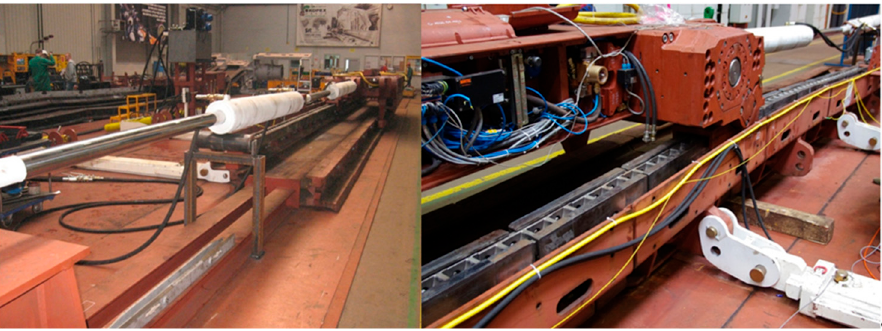
Figure 4. View of the special test rig for conducting comparative tests of the Flextrack and Eicotrack haulage systems.